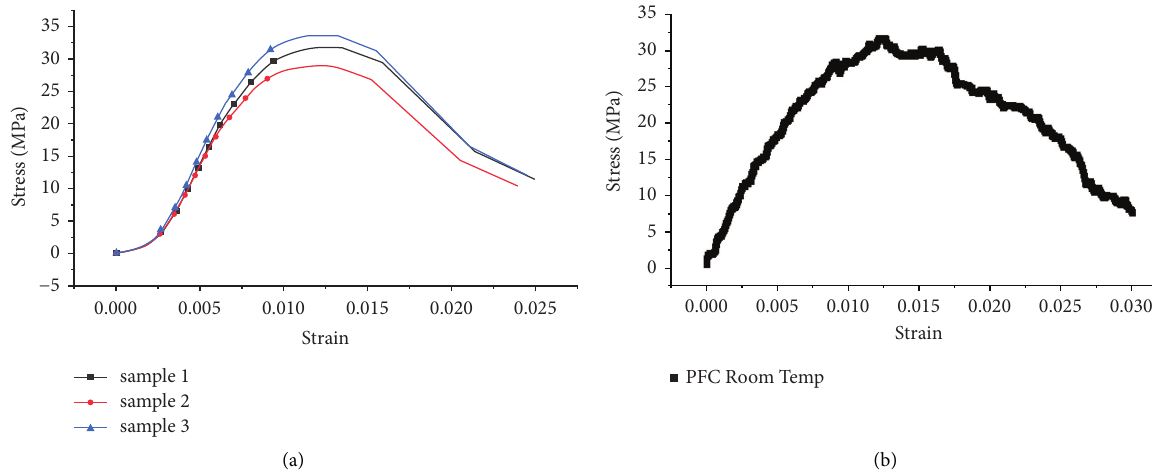
Figure 12: The concrete UCT stress-strain curves at room temperature: (a) the experiment results and (b) the PFC 2D result.